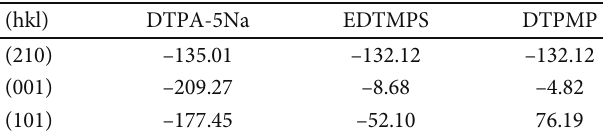
) DPTA-5Na, (b ) EDTMPS, and (c 3 3 5Na, EDTMPS, DTPMP, and BaSO 4 Figure 4.For the three inhibitors to be adsorbed on BaSO